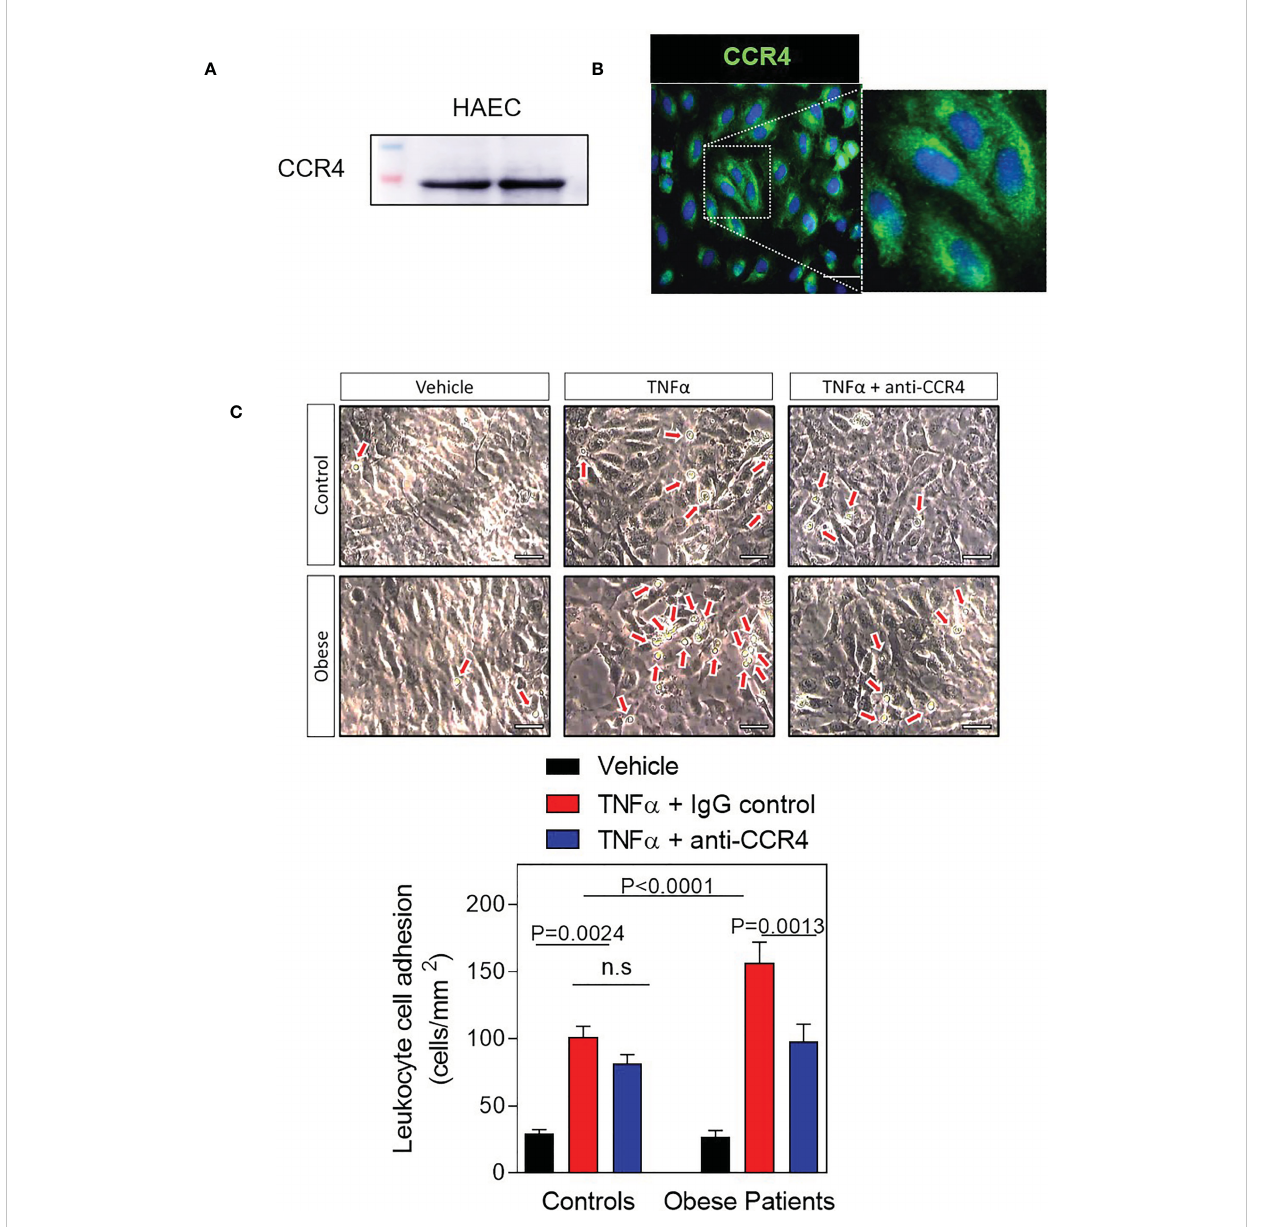
FIGURE 4 Ex vivo blockade of CCR4 receptor decreases TNF a -induced leukocyte-endothelial cell adhesion in obese patients. (A) Protein CCR4 expression in human aortic endothelial cells (HAEC) (B) Immuno fl uorescence of representative images showing CCR4 expression in HAEC. Scale bar, 50 m m. (C) Con fl uent HAECs were stimulated or not with TNF a (20 ng/mL) for 24 h. In parallel, some samples were preincubated with a monoclonal neutralizing antibody against human CCR4 receptor (3 m g/mL). Diluted heparinized whole blood (1:10) from patients (n=16) or healthy controls (n=9) was perfused across endothelial cells monolayers for 5 min at 0.5 dyn/cm 2 . Values are expressed as mean ± SEM. Representative images show adhered leukocytes to endothelial cell monolayer. Scale bar, 100 m m. Comparisons between groups were made with 1-way